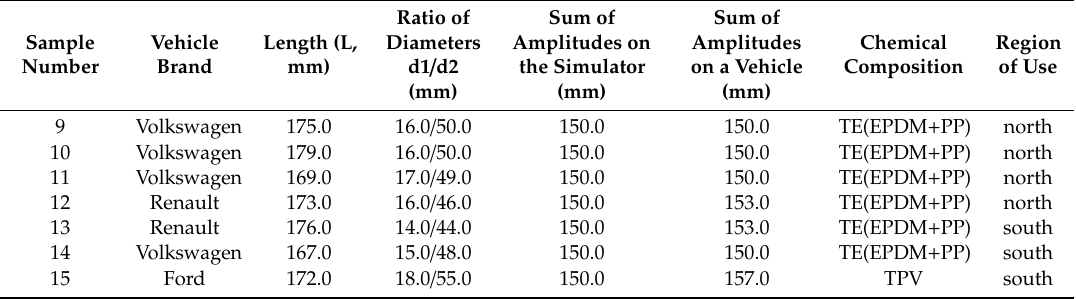
Table 4. The basic data of the second group of cu ff s before the test